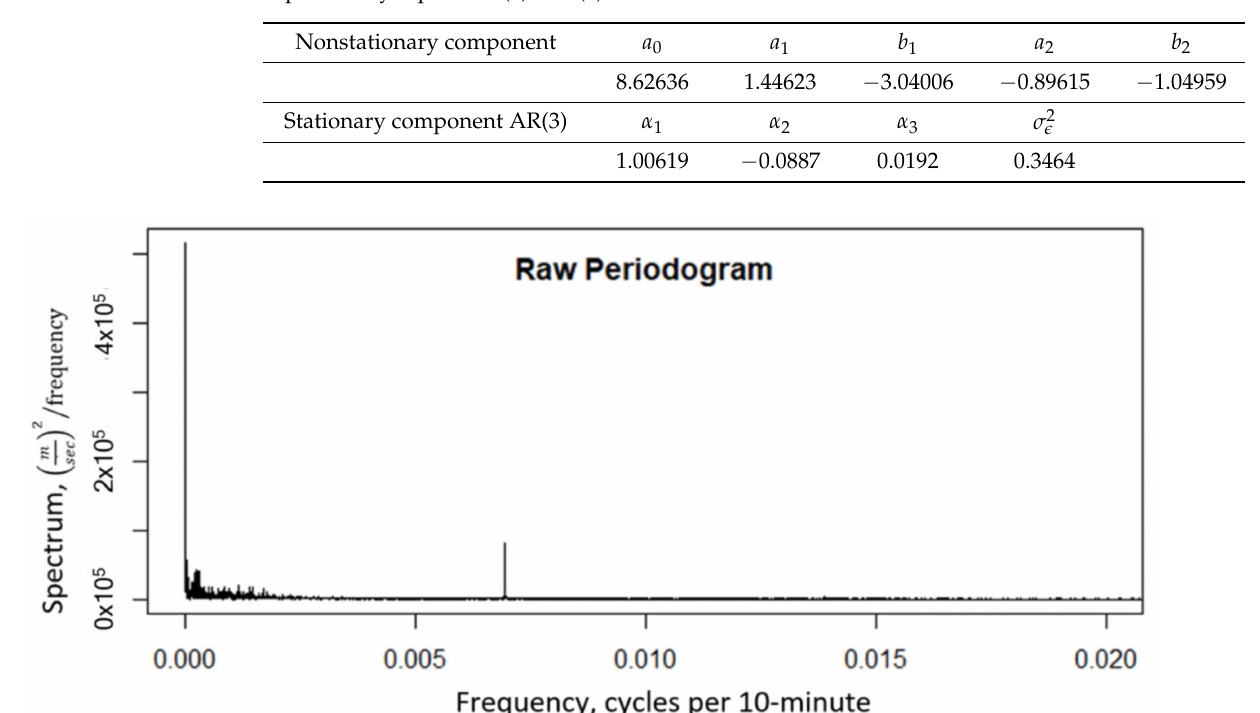
Table 1. Parameters of the time series model of wind speed at 100 m height. The time series model is expressed by Equations (1) and (2).